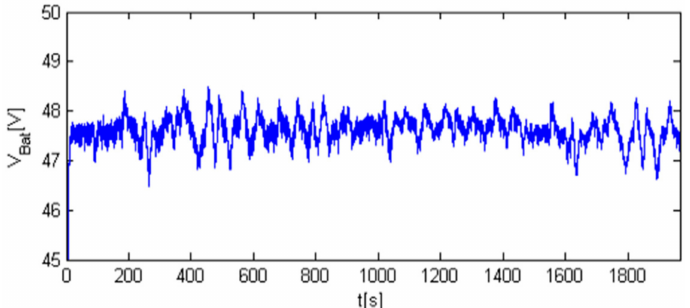
Figure 31. Battery terminal voltage.